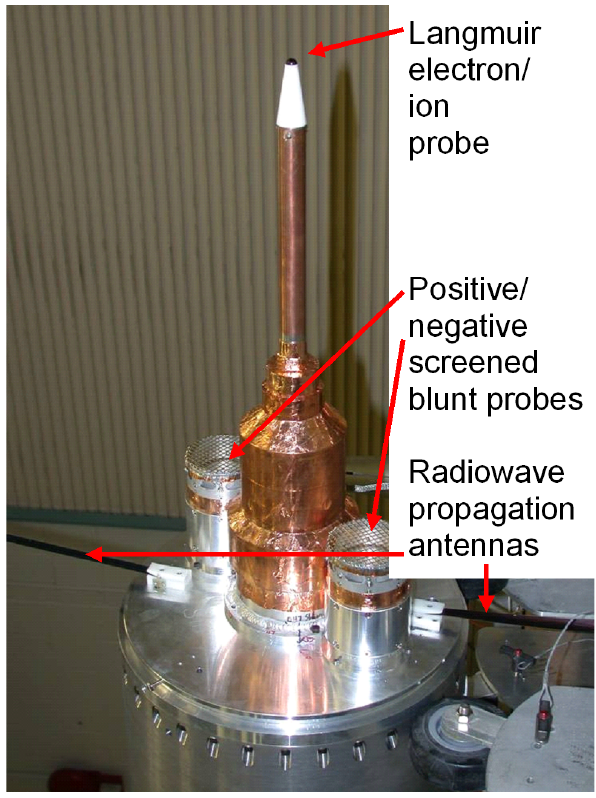
Fig. 1. Instrument configuration for the Terrier-Orion rockets of the MaCWAVE